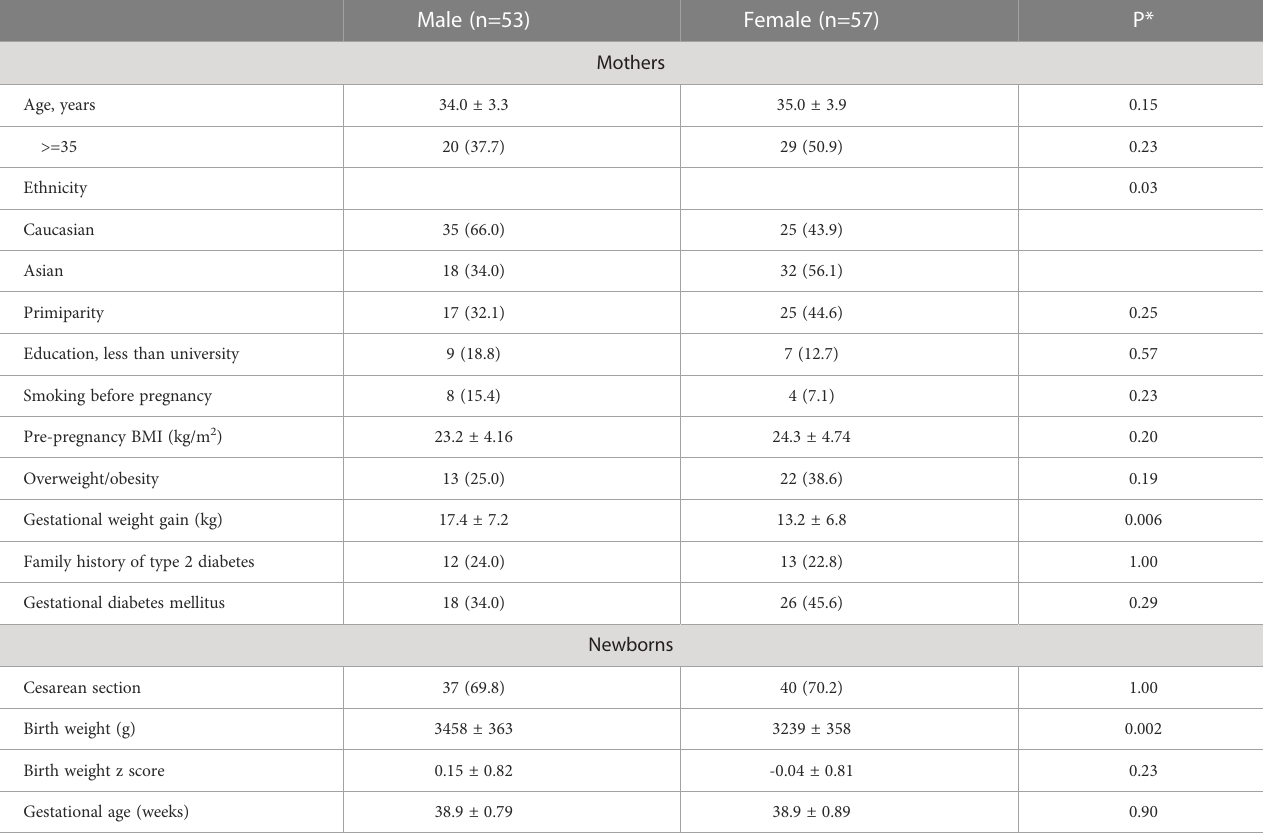
TABLE 1 Characteristics of mothers and newborns by infant sex